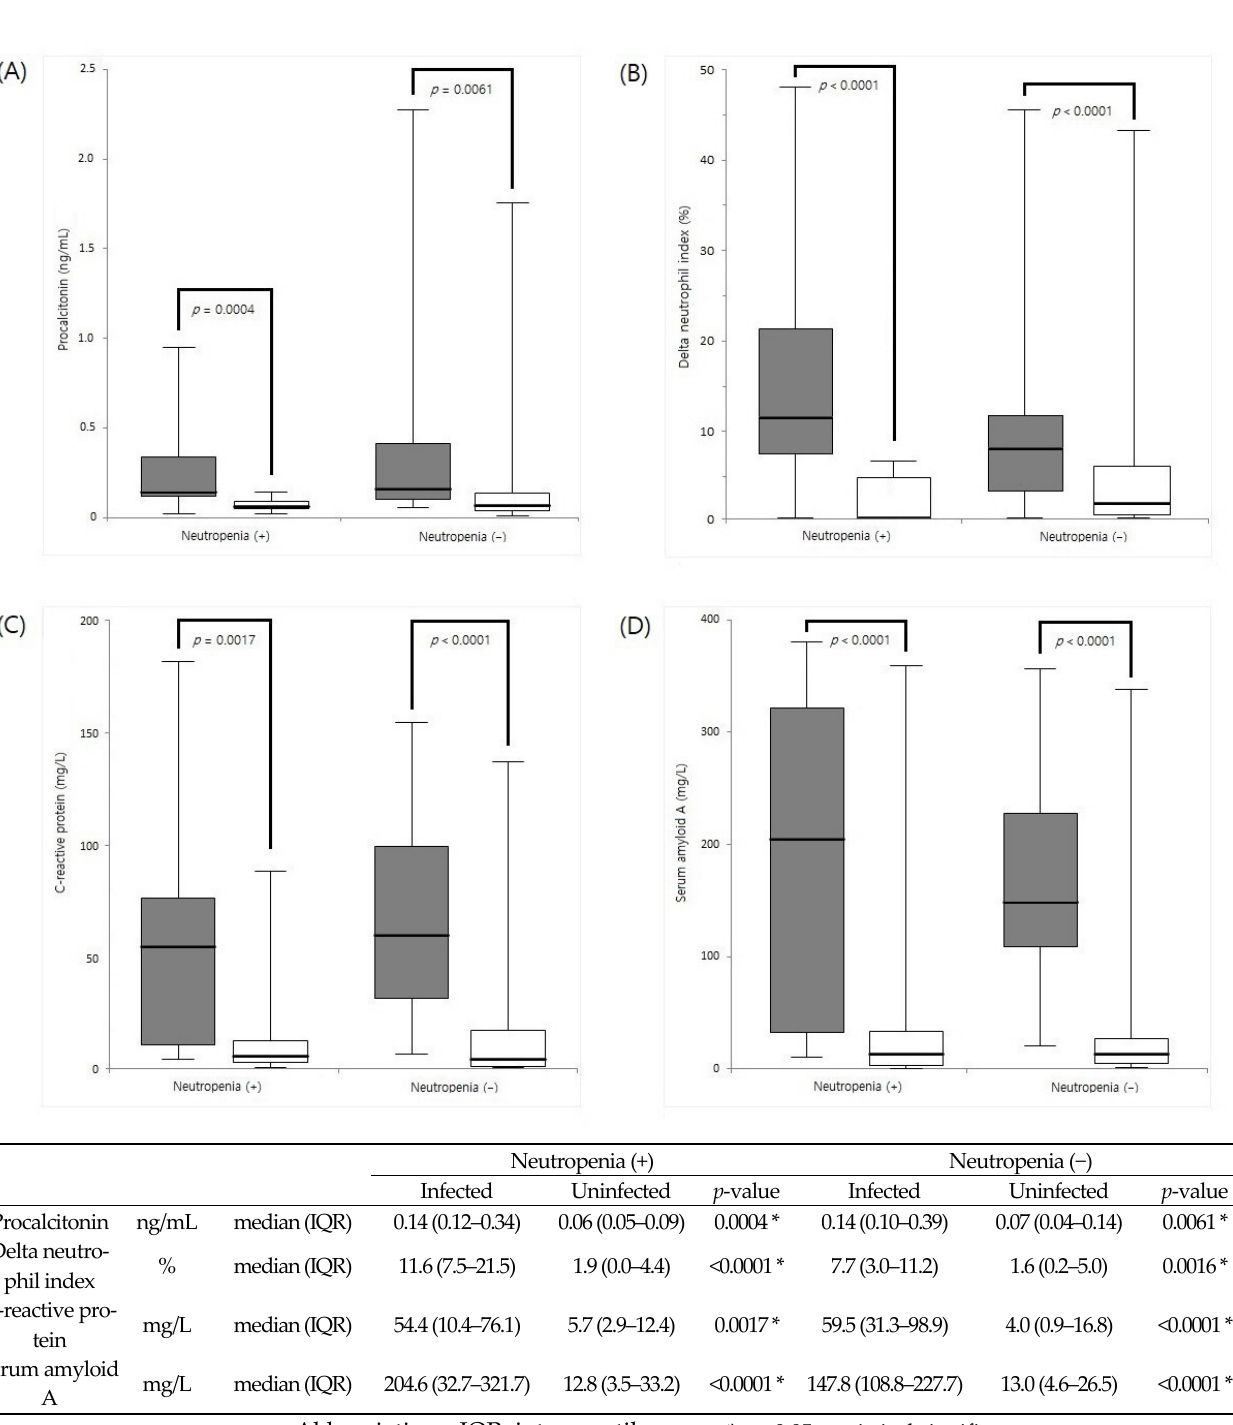
Figure 1. Comparison of ( A ) procalcitonin, ( B ) delta neutrophil index, ( C ) C-reactive protein, and ( D ) serum amyloid A between patients with and without neutropenia.